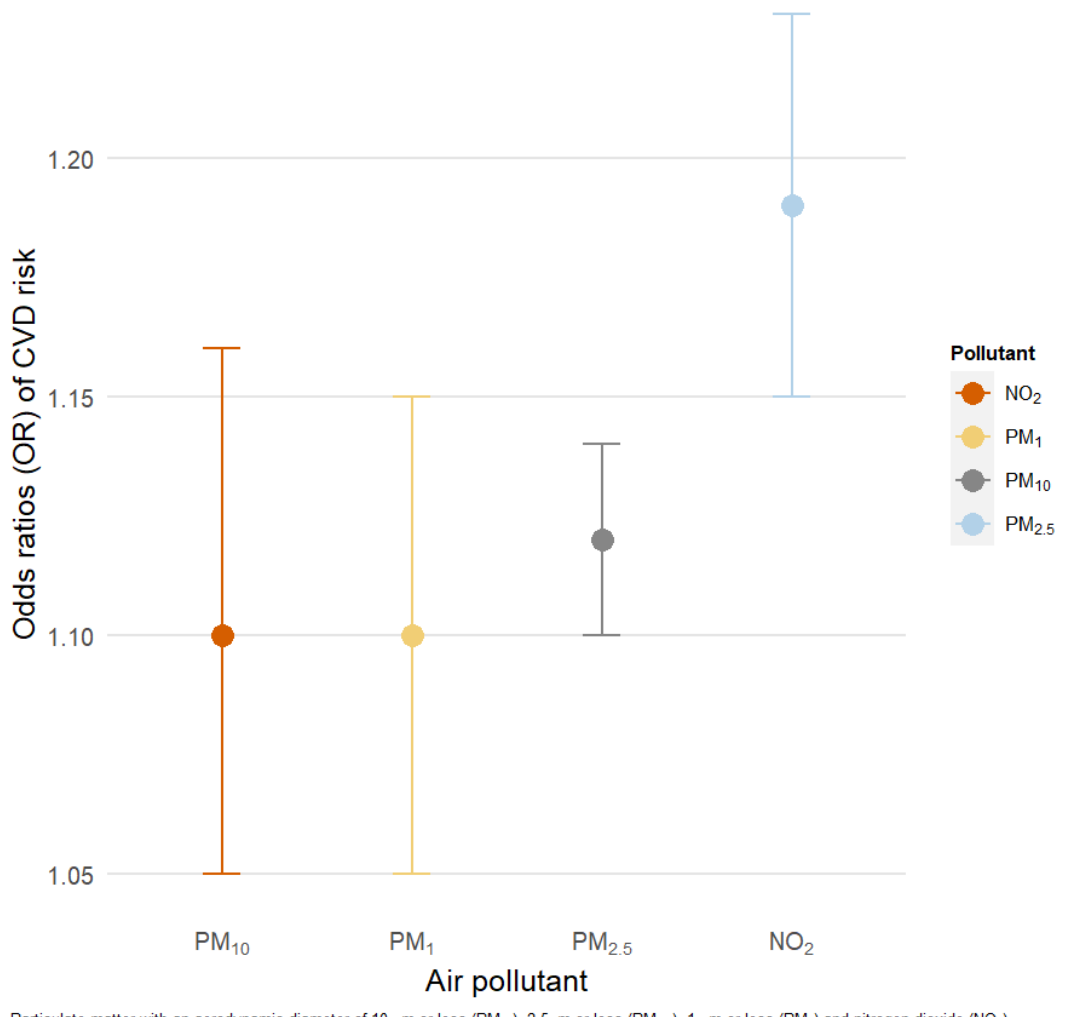
Figure 3. Association between a 10 µ g/m 3 increment in 3 year moving averages of air pollution and CVD risk. Models adjusted for age, sex, BMI, tobacco use, physical activity, education level, fruit and vegetable intake, alcohol use, type of fuel used at home, median household income, and location of residence (urban/rural). OR = odds ratio.